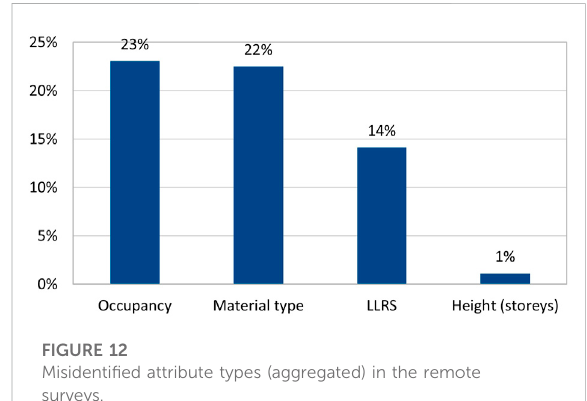
FIGURE 12 Misidenti fi ed attribute types (aggregated) in the remote surveys.